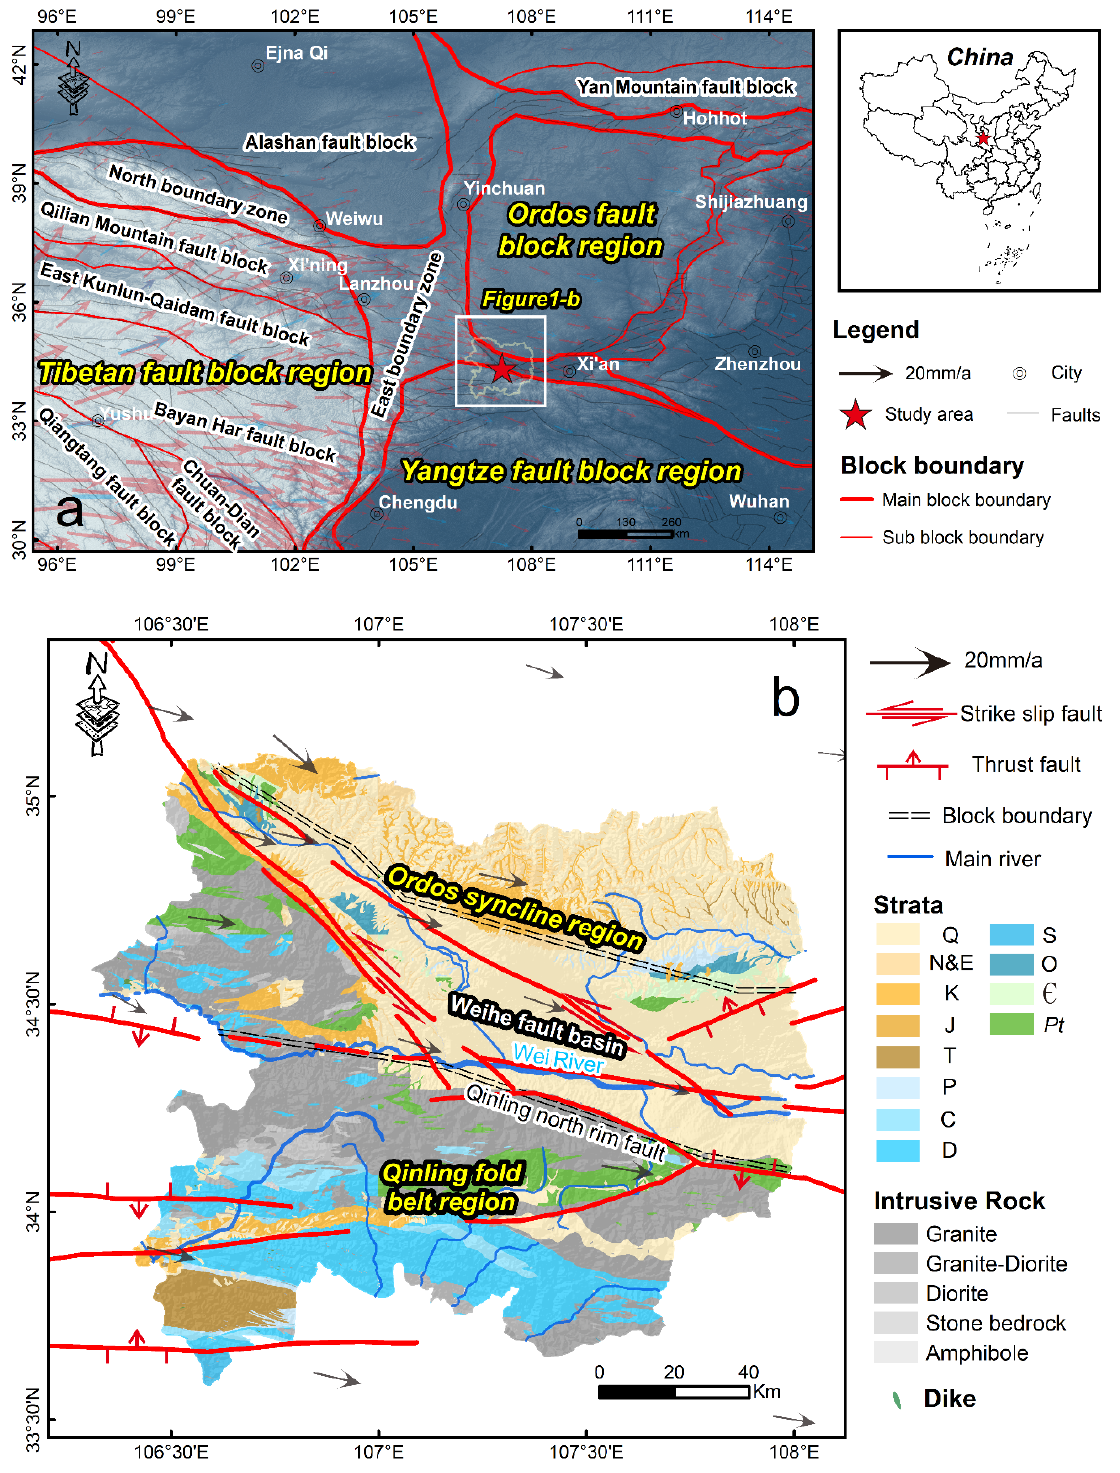
Figure 1. Geological setting of Baoji. ( a ) Baoji is located at the plate junction, regional GPS velocity (red represents the campaign stations, time period: 2009–2014; blue represents continuous stations, time period: 1998–2014). ( b ) Distribution of lithology in the study area (according to stratigraphic ages), regional GPS velocity (campaign stations, time period: 2009–2014). The GPS velocity ( a , b ) is from Zhao et al. [27], fault block information ( a ) is from Deng et al. [28]. Strata: Q—Quaternary, N&E—Tertiary, K—Cretaceous, J—Jurassic, T—Triassic, P—Permian, C—Carboniferous, D—Devonian, S—Silurian, O—Ordovician, ∈— Cambrian, Pt -—Proterozoic.